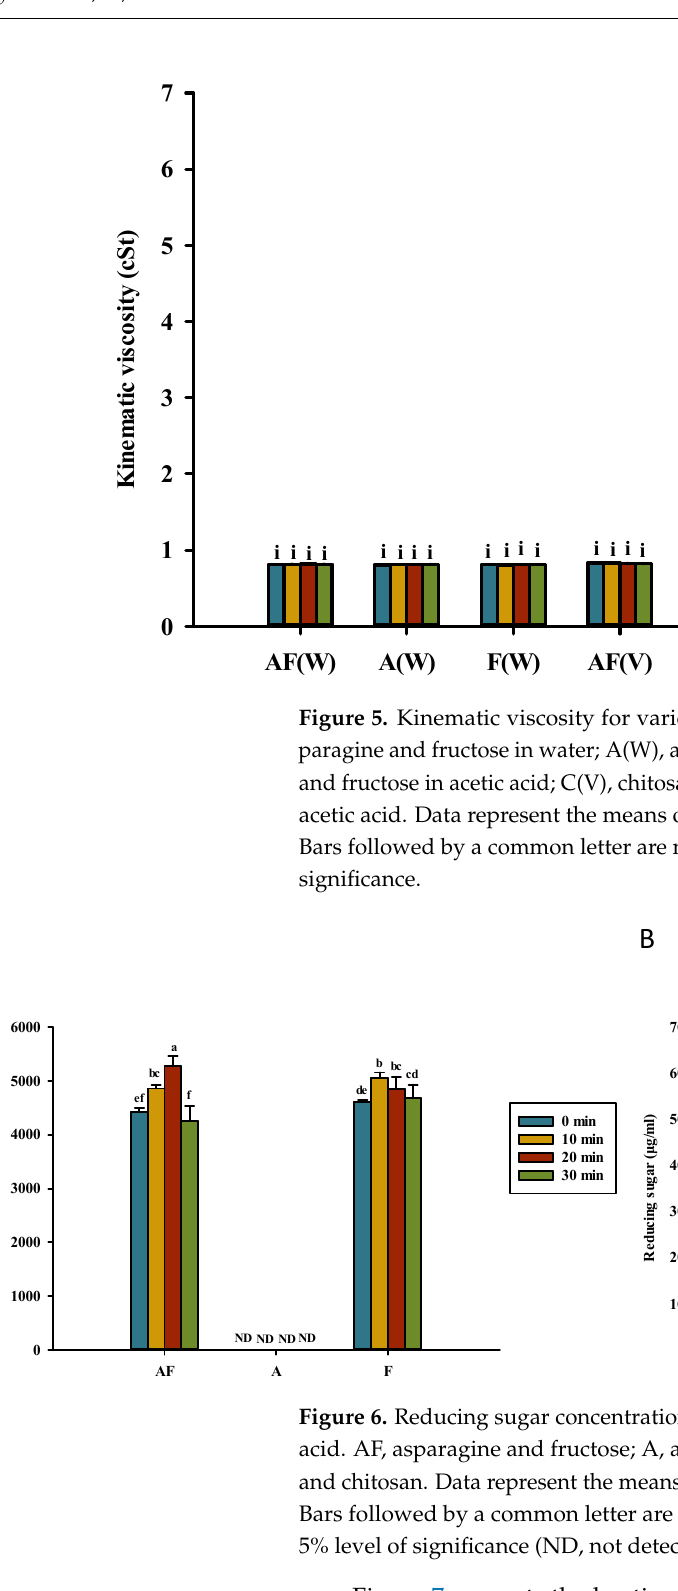
( B ) Figure 7. Asparagine content for various groups upon heating in ( A ) water and ( B ) acetic acid. AF, asparagine and fructose; A, asparagine; AFC, asparagine, fructose, and chitosan. Data represent the means of three replicates, and error bars indicate standard deviation. Bars followed by a common letter are not significantly different according to the Dunn’s test at the 5% level of significance. A larger reduction in pH was observed in fructose dissolved in water after heating for 30 min (Figure 8A). In acetic acid solution, the pH of 0.5% chitosan remained constant